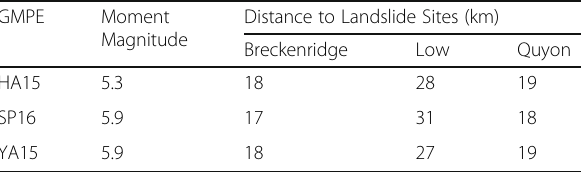
Table 3 Summary of estimated earthquake magnitude and location